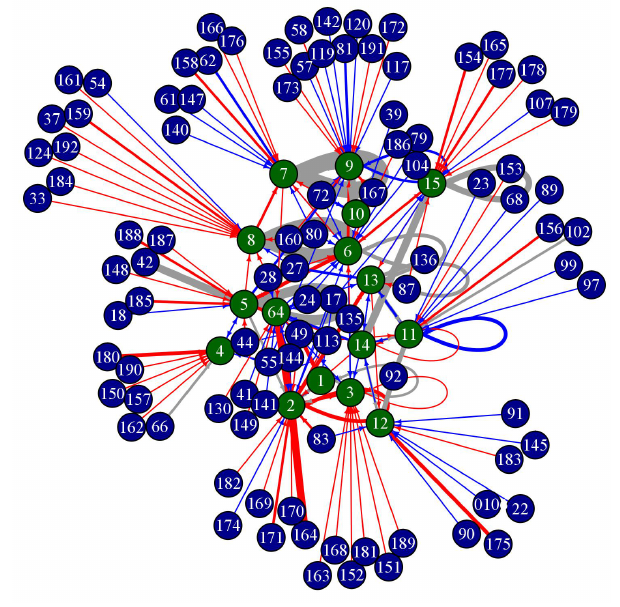
Fig. 3 . The aggregate network of seed acquisitions for the two cropping seasons. Interviewed households are nodes in green, and providers not interviewed are nodes in blue. The colors of the edges represent the year of the seed acquisitions (blue for 2010, red for 2011, grey if the transaction occurred both years). Loops represent seed acquisitions within the household i.e., from one household member to another. The width of an edge represents the number of observed events between pairs of nodes (ranging from 1 to 13). The density of this unidirectional network is